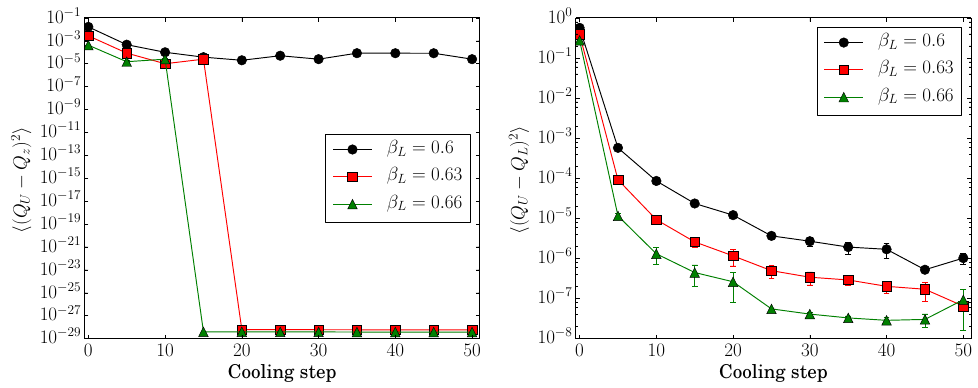
Figure 1 . Average squared difference between different definitions of the topological charge as a function of the number of cooling step. Data have been collected for N = 21, θ L = 0 and different values of β L . Typical error bars are smaller than the symbol